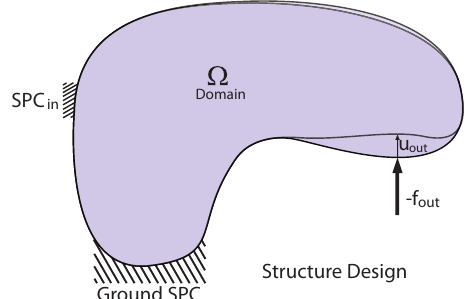
Figure 2. Structure design: stiffness to bear loads.